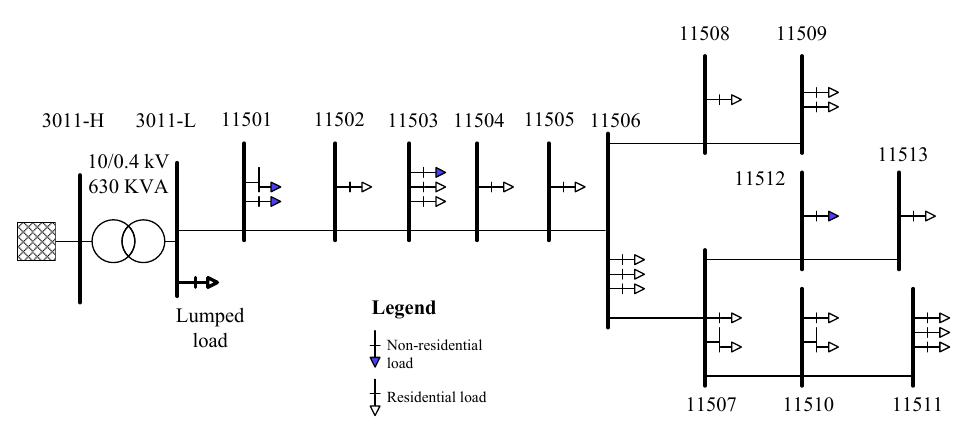
Figure 4. Schematic diagram of a simplified radial LV feeder in Thisted, Denmark.